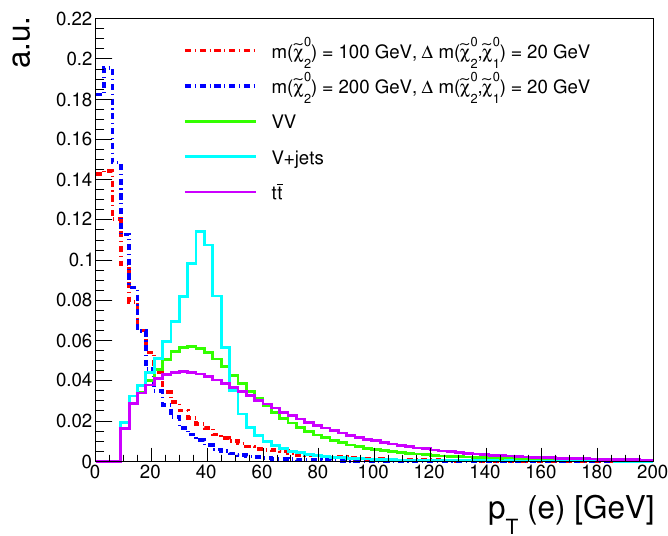
Figure 6 . p T distribution for electrons with p T > 3 GeV and | η | < 2 . 5 , for two benchmark signal points and major